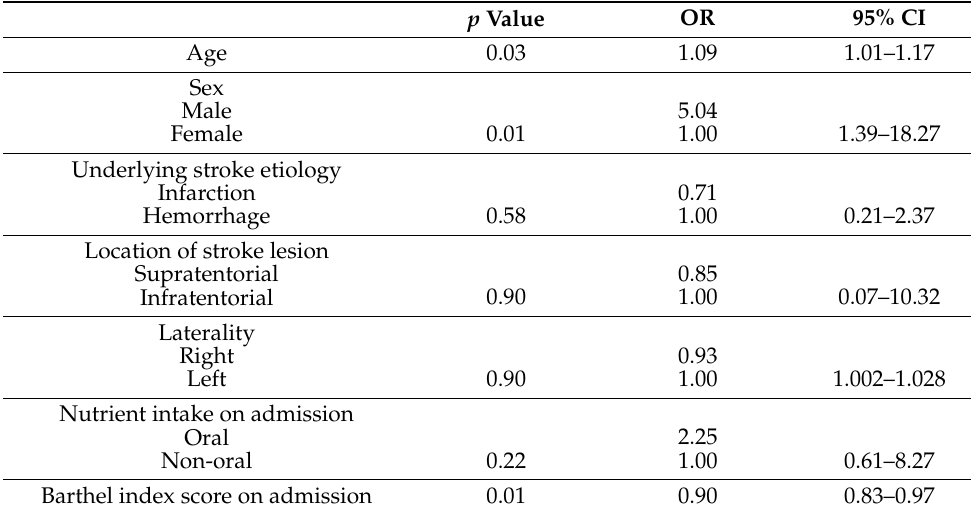
Table 2. Results of the polytomous logistic regression analysis.